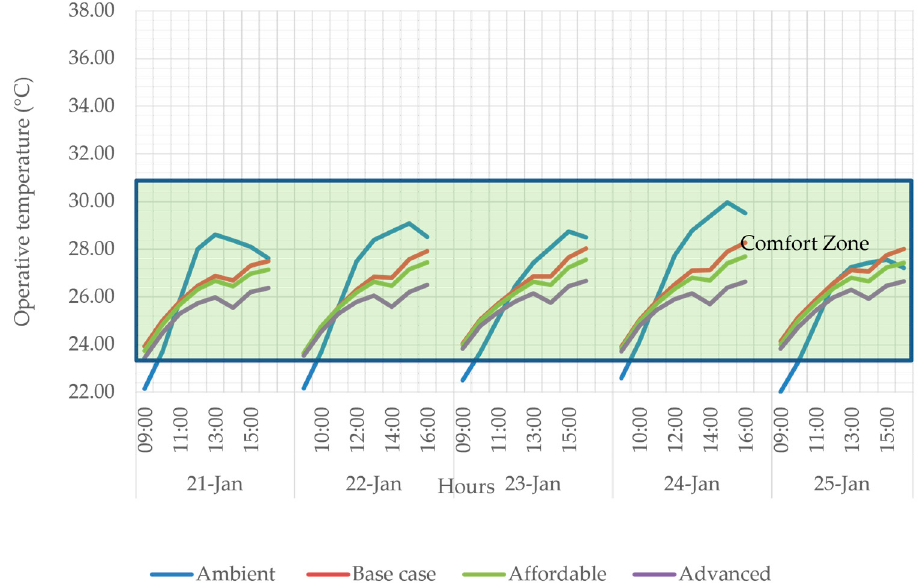
Figure 8. Reduction in temperature from the BC in a winter week.